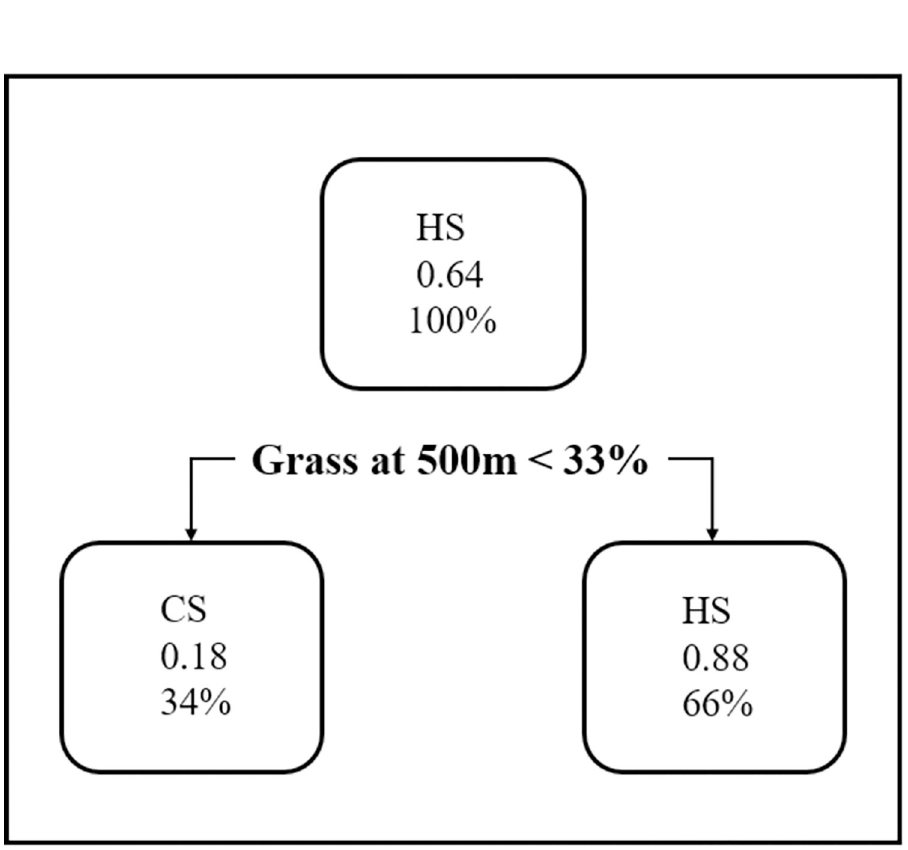
Fig 6. Classification tree model of the influence of landscape attributes on pheasant HotSpots (HS) and Coldspots (CS) at different spatial scales (500 m and 1000 m).